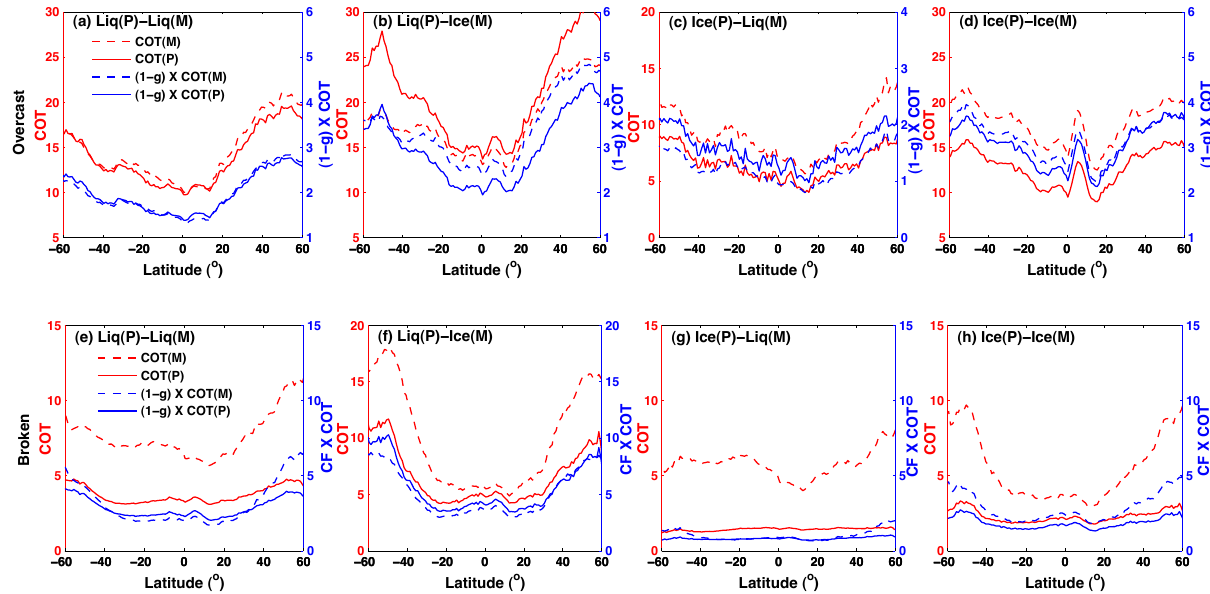
Fig. 2. First line: latitudinal variations of MODIS and POLDER COT (left axis: red) and the scaled COT calculated by (1 − g) × COT (right axis: blue) for 4 different overcast clouds classes determined by cloud combined phase: POLDER-liquid and MODIS-liquid (a) , POLDER- liquid and MODIS-ice (b) , POLDER-ice and MODIS-liquid (c) , POLDER-ice and MODIS-ice (d) . Second line: latitudinal variations of MODIS and POLDER COT (left axis: red) and the product CF × COT (right axis: blue) for 4 different broken clouds classes determined by cloud combined phases: POLDER-liquid and MODIS-liquid (e) , POLDER-liquid and MODIS-ice (f) , POLDER-ice and MODIS-liquid (g) , POLDER-ice and MODIS-ice (h) . In the legends, letter M stands for MODIS and letter P for